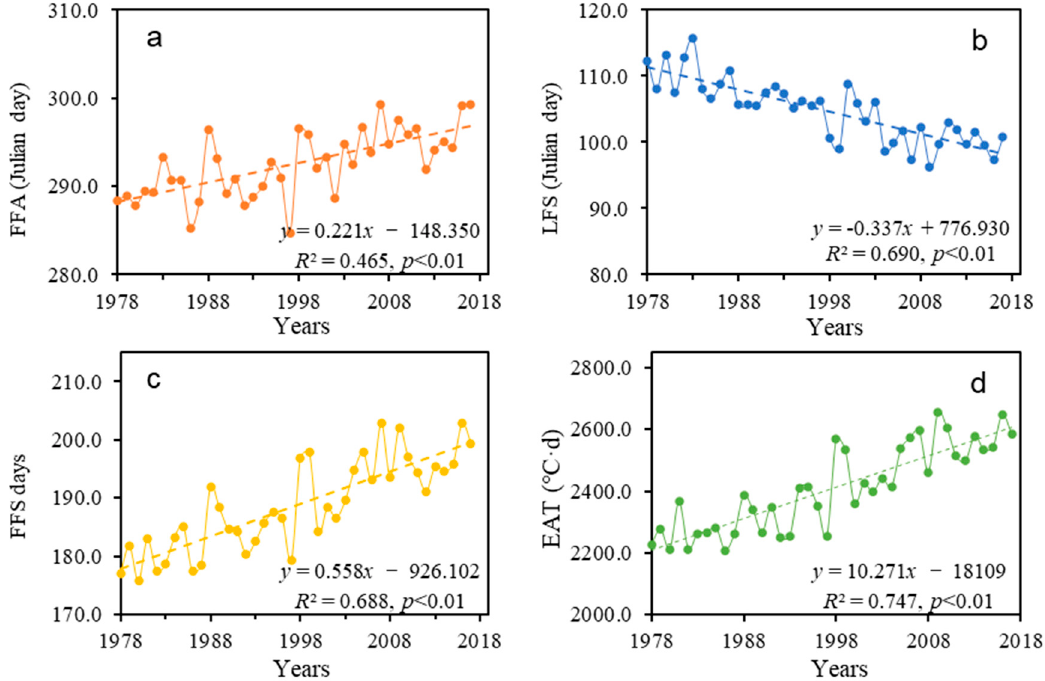
Figure 2. Changes in FFA, LFS, FFS and EAT on the Qinghai–Tibetan Plateau from 1978 to 2017.